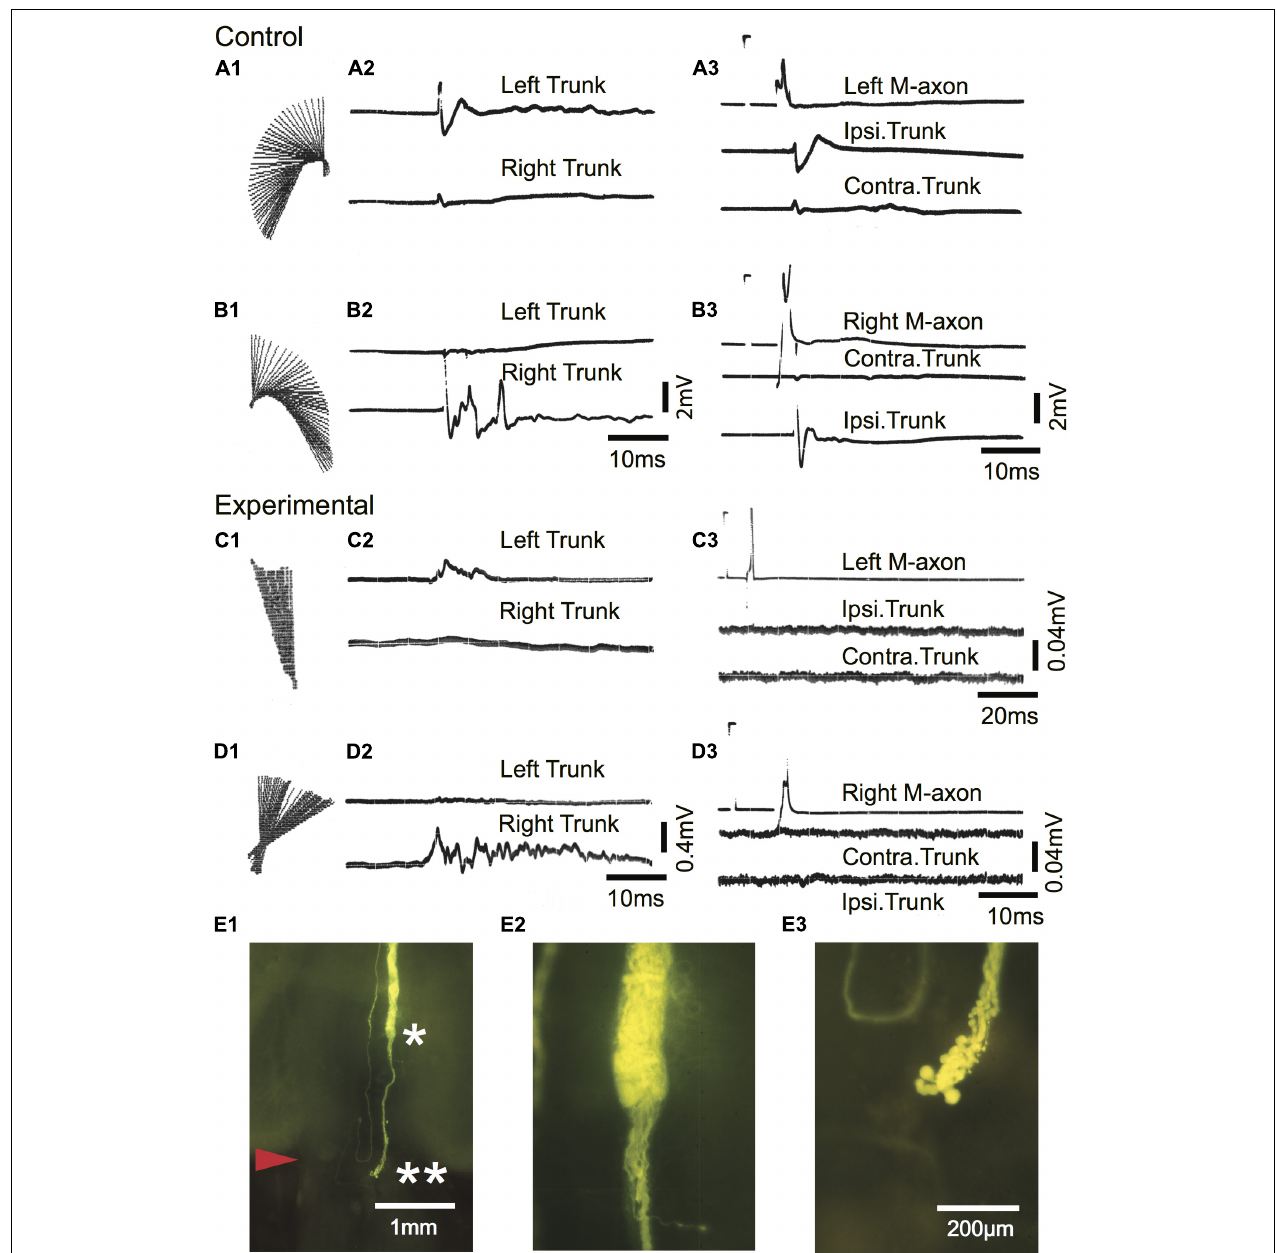
FIGURE 10 | Mauthner-axons do not contribute to the post-injury startle response of a free-swimming goldfish 612 days after SML crush. (A1–B3) Sham-operated control fish 588 days postoperatively. (A1,B1) C-type startle response to the left (A1) and right (B1) side in a free-swimming goldfish. Regression lines of the rostral 40% of the fish body are plotted in 2 ms increments [see Figure 2 of Zottoli and Freemer (2003) for a more detailed description]. (A2,B2) EMG recordings from left (upper trace) and right (lower trace) trunk musculature during the free-swimming responses shown in panels (A1,B1) . The EMGs correspond to the direction of the behavioral response. (A3,B3) Fish were moved from the sound test chamber to a holding chamber, and threshold activation of M-axons resulted in ipsilateral EMG recordings. Calibrations in panel (B2) are the same for panel (A2) and calibrations for panel (B3) are the same for panel (A3) . (C1–D3) Experimental fish 612 days after SML crush. (C1,D1) Post-injury startle responses to the left (A1) and right (B1) side in a free-swimming goldfish. (C2,D2) EMG recordings from left (upper trace) and right (lower trace) trunk musculature during the free-swimming responses shown in panels (C1,D1) . The EMGs correspond to the direction of the behavioral response. (C3,D3) Fish were moved from the sound test chamber to a holding chamber, and threshold activation of M-axons did not result in trunk EMGs. Calibrations in panel (D2) are the same for panel (C2) . The calibration pulse on the axon trace of C3 is 60 mV, 1 ms and 40 mV, 1 ms for panel (D3) . (E1–E3) Lucifer yellow fill of the right axon of the experimental fish. (E1) Low power image of the brain wholemount. An enlargement of the region to the left of the single asterisk is shown in panel (E2) and to the left of the double asterisk in panel (E3) .